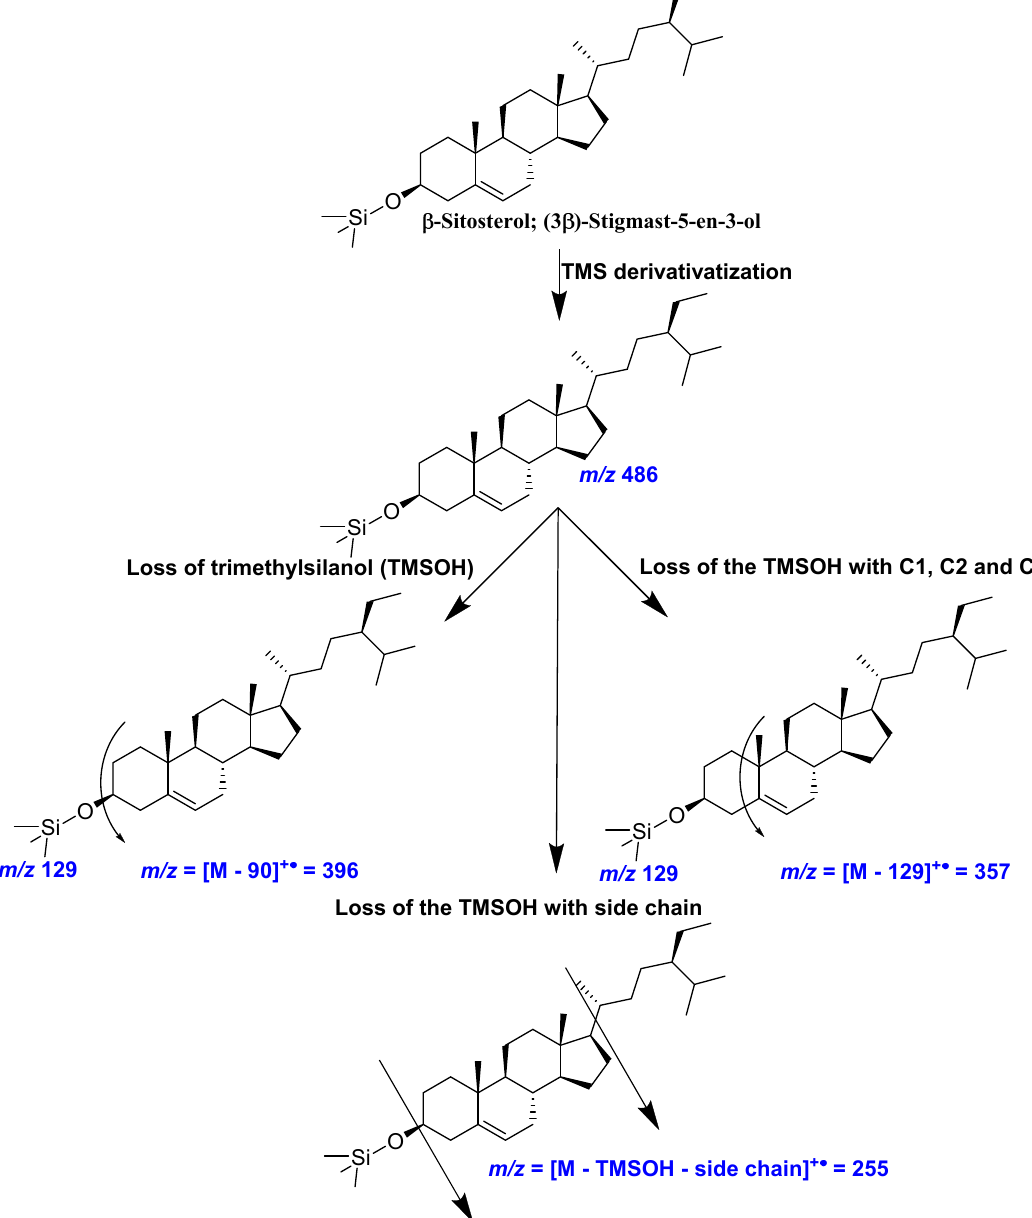
Figure 4 . The mass spectrometric fragmentation pattern of β‐ sitosterol (TMS derivative) observed in the present study Figure 4. The mass spectrometric fragmentation pattern of β -sitosterol (TMS derivative) observed in the present [26 – 28] . study